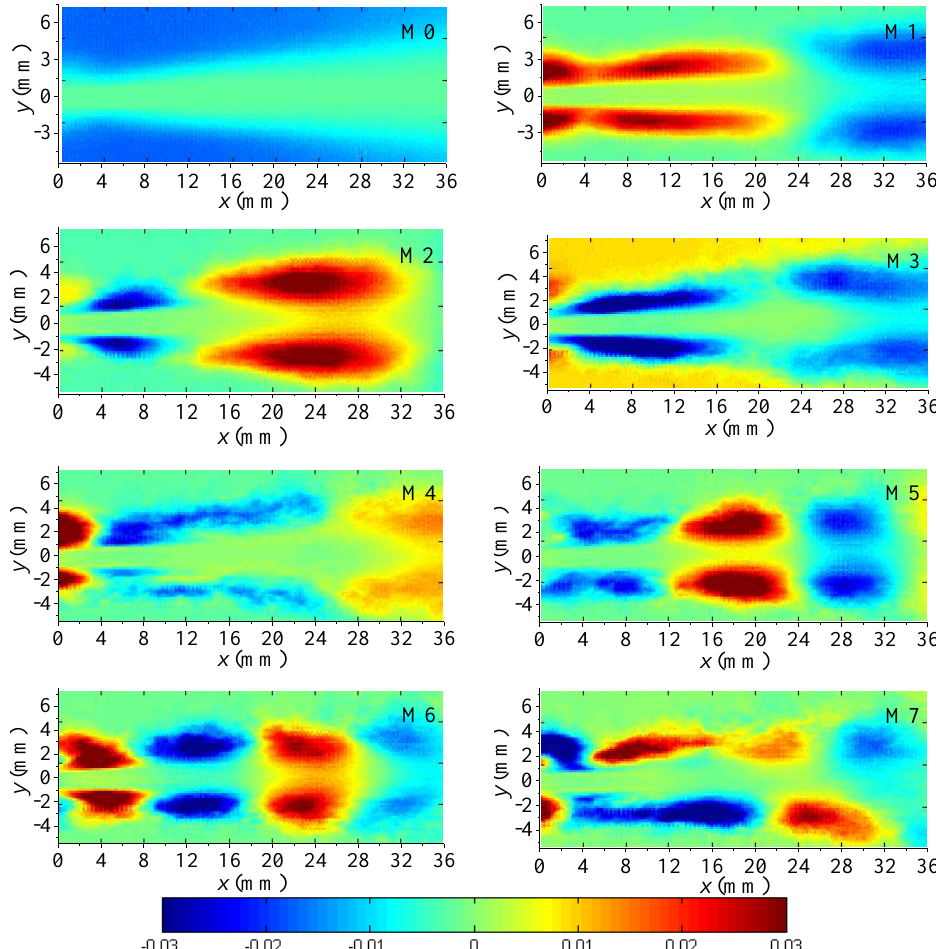
Figure 6. Spatial distribution of mode_0 to mode_7 of cavitation bubbles.